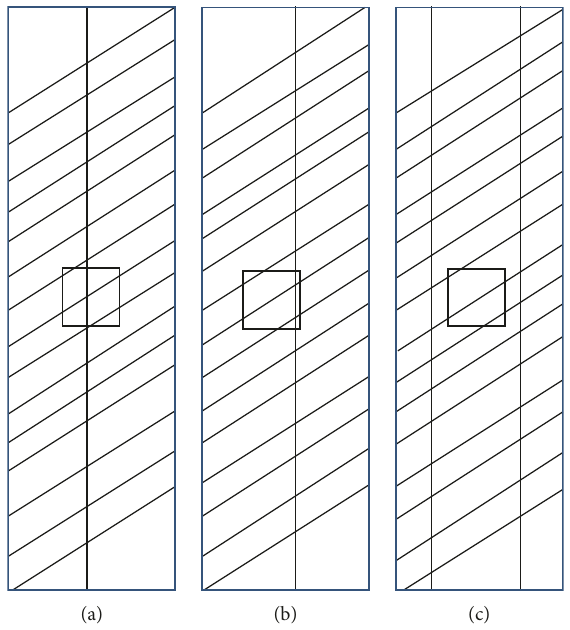
Figure 4: Schematic of defect location. (a) Defect located on access tube, (b) defect shifted from access tube, and (c) defect located between access